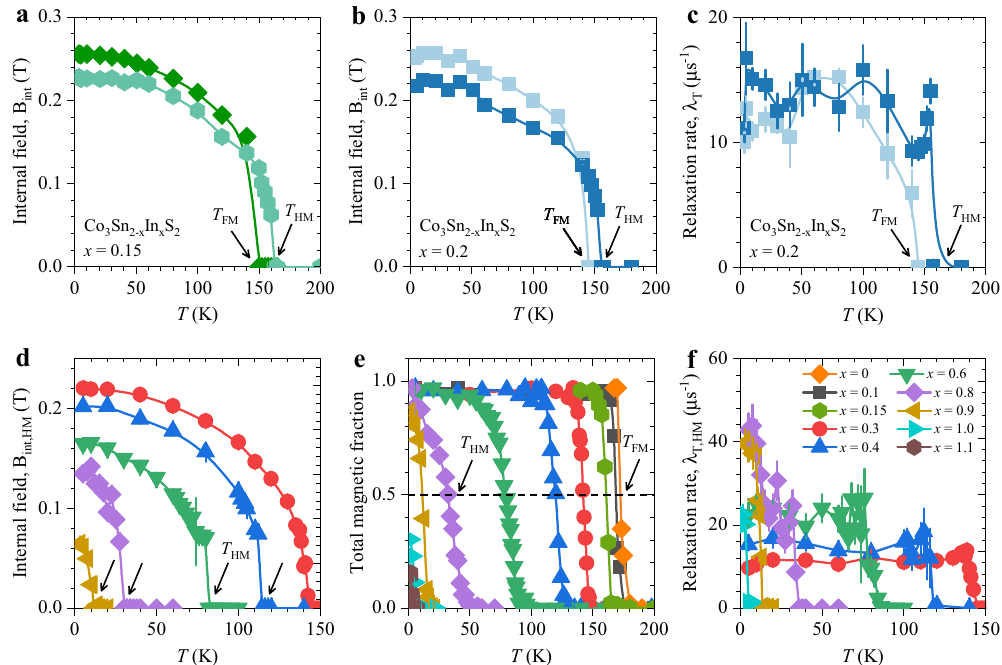
Fig. 4 (Color online) The temperature dependence of various fi t parameters of the μ SR experiments. The temperature dependences of the internal magnetic fi elds of the two magnetically ordered regions in the samples x = 0.15 ( a ) and 0.2 ( b ). c The temperature dependence of the transverse relaxation rates of the two magnetically ordered regions in the sample x = 0.2. Arrows mark the critical temperatures T FM and T Hel for FM and helical magnetic components, respectively. The temperature dependences of the average value of magnetic fi elds ( d ) and the transverse relaxation rates ( f ) for the helical magnetic component shown for various In-doped samples. e The temperature dependence of the total magnetic volume fraction for various In-doped samples. The error bars represent the s.d. of the fi t parameters. Arrows in e mark the temperature at which the magnetic fraction is